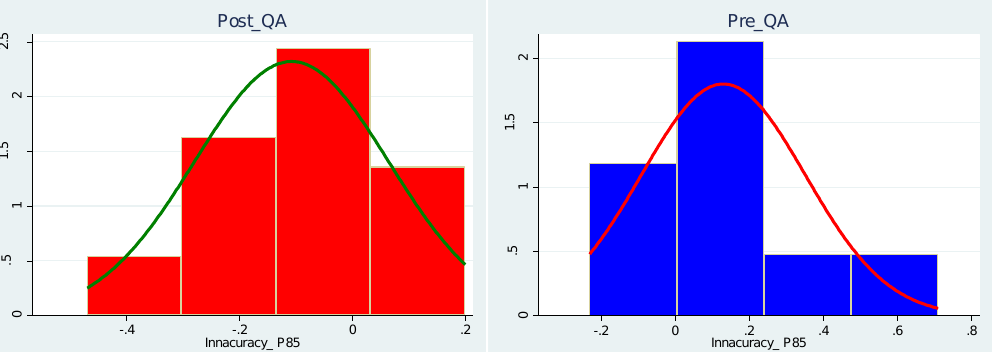
Figure 3. A comparison of the distributions of PCOs between post- and pre-quality assurance periods It is clear from Figure 3 that the post-quality assurance distribution of PCOs is skewed to the left, while that of the pre-quality assurance is skewed to the right. The mean percentage cost overruns (MPCOs) are negative and positive for the post- and pre-quality assurance periods, respectively, indicating that quality assurance led to under-runs while pre-quality assurance had